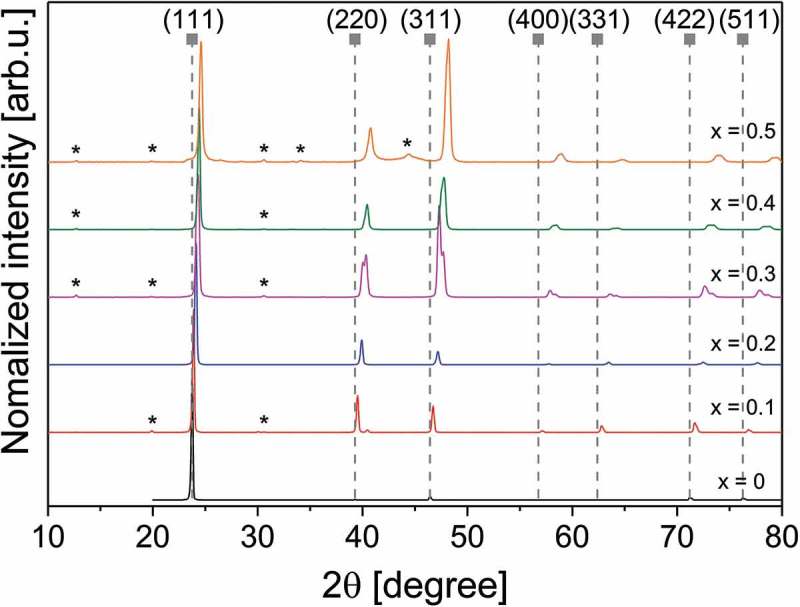
X-ray diffractograms of CdTe1-xSex thin films on glass substrate. The symbols indicate the CdTe reference from [18] (PDF number 01–070–8041).